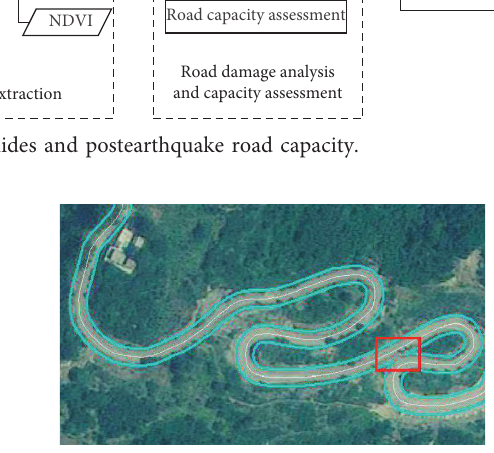
Figure 4: Winding road buffer with intact and dissolved